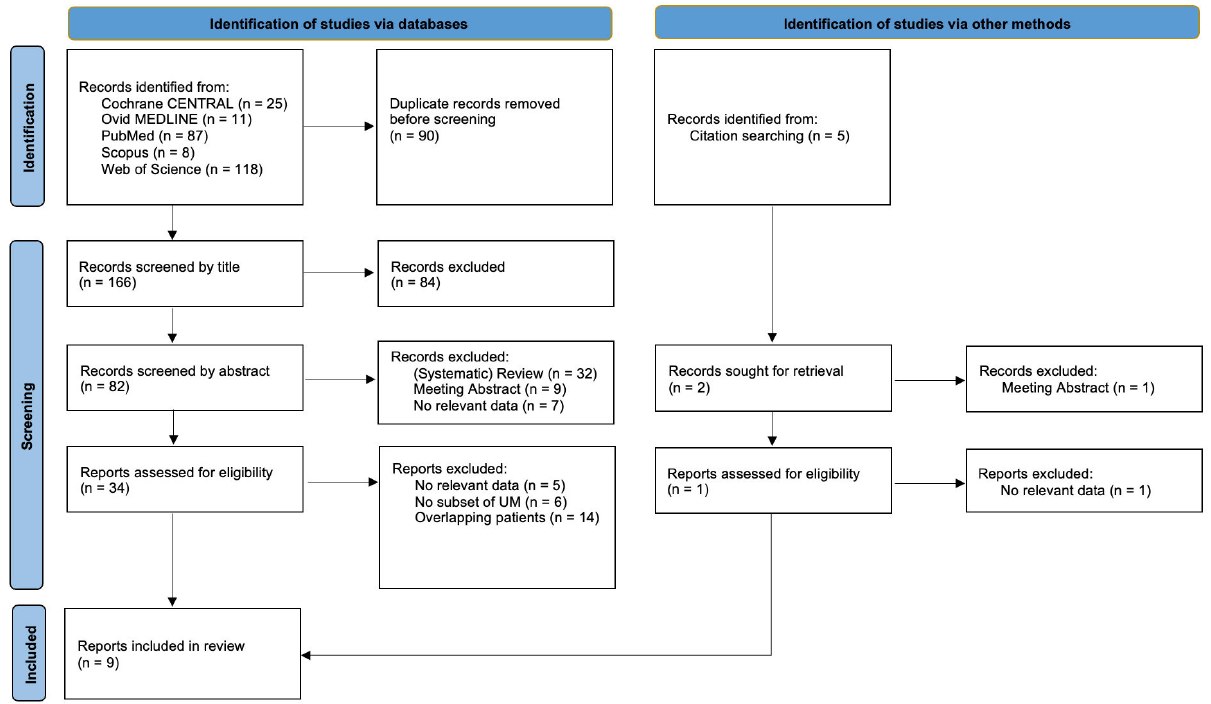
Figure 1. Search flow diagram. UM: uveal melanoma. Table 1. Patient series characteristics.